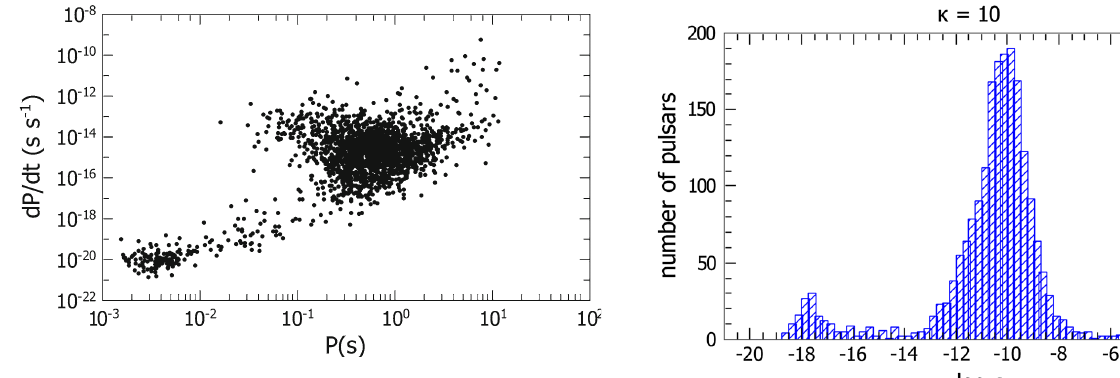
Fig. 1 The P – ˙ P diagram for radio pulsars obtained from the ATNF Pulsar Catalog (http://www.atnf.csiro.au/people/pulsar/psrcat/)